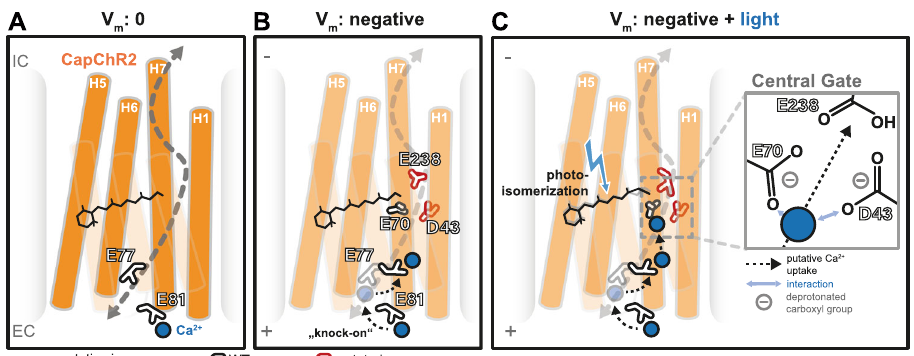
Fig. 8 | Proposed model for Ca 2+ -permeation and inward recti fi cation in CapChR2basedonMDsimulations.A StablebindingofCa 2+ toE81intheabsence of membrane voltage ( V m ) and no illumination. B Upon the application of a nega- tivemembranepotential,asecondCa 2+ ionbindstoE81andthe fi rstionisdisplaced into the pore ( “ knock-on ” ), where it binds E77 and fl ips towards the central gate.